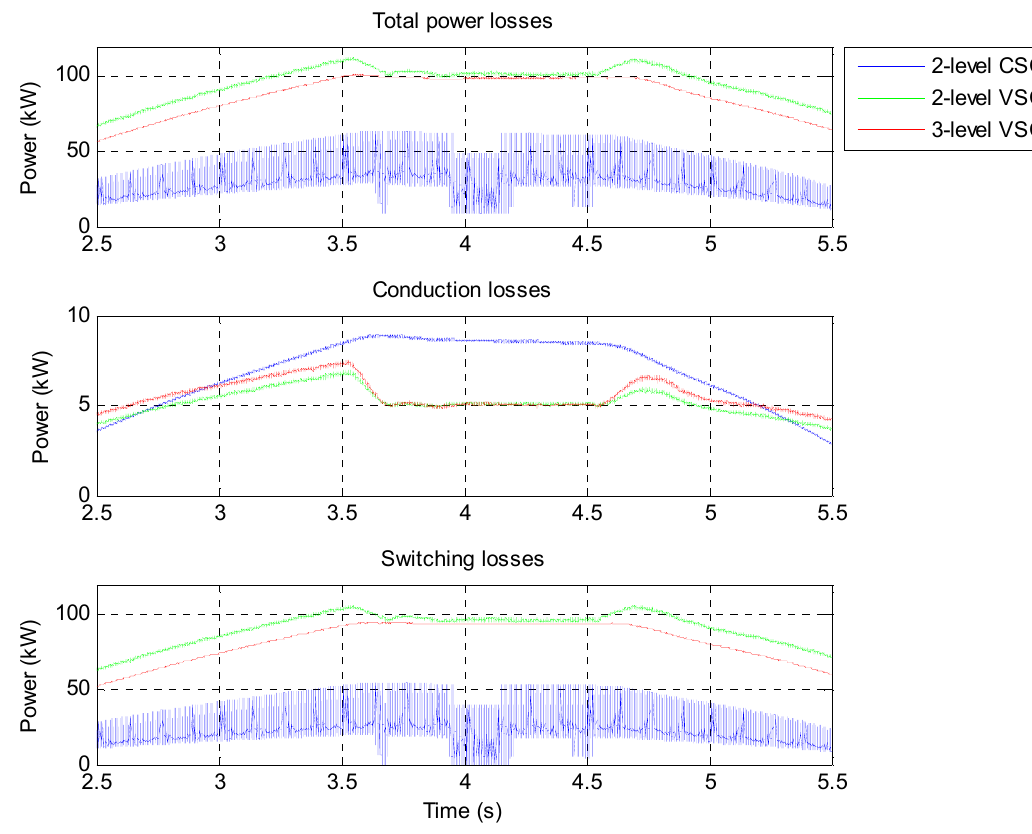
Figure 22. Comparison of the power losses in each